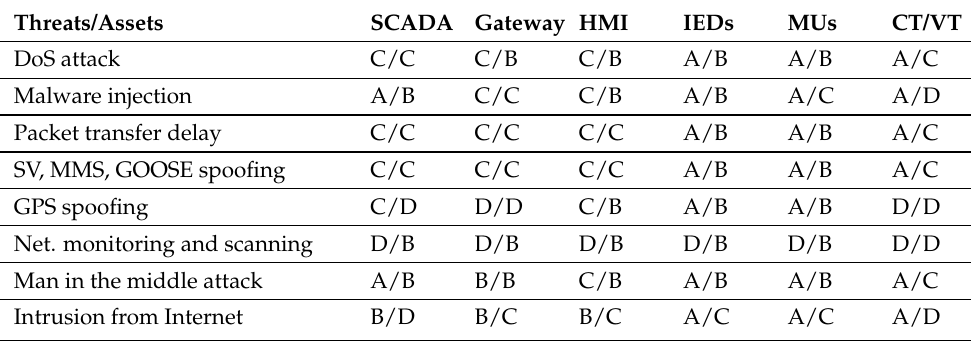
Table 1. An example of a threat analysis table. Adapted from